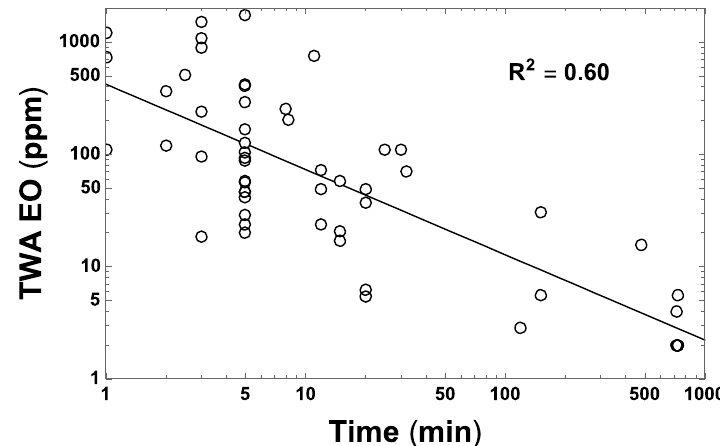
Figure 4. Fifty-five measures (open points) of TWA EO concentration made around sterilization chambers in the spice sterilization facilities listed and cited by Goldgraben and Zank [16], in relation to corresponding reported durations ( t , in min) over which these measurements were made. The straight line shows the corresponding unweighted log–log linear regression fit to these data, EO TWA = 419.65( t / min) − 0.7592 ppm ( p = ~0, R 2 = 0.60), which predicts an 8 h TWA EO concentration of approximately 3.9